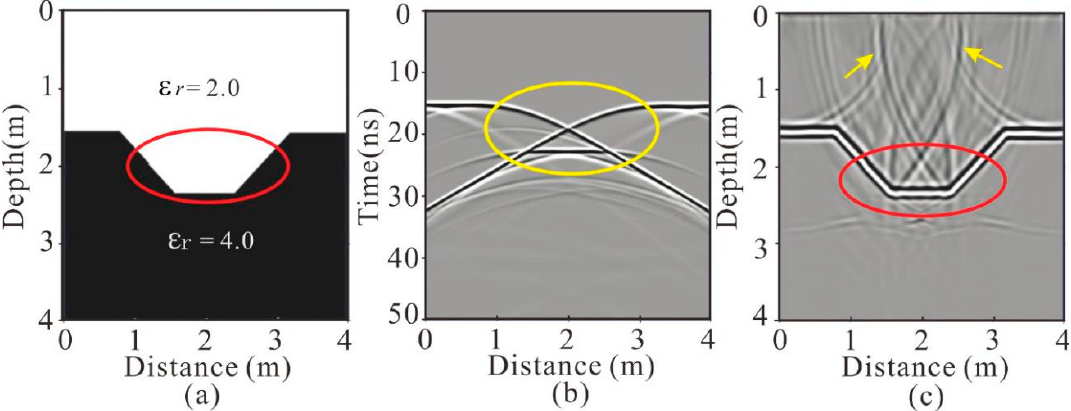
Figure 3. The imaging of RTM of groove model: ( a ) dielectric constant mode, ( b ) radar profile after removing the direct wave and ( c ) RTM profile.